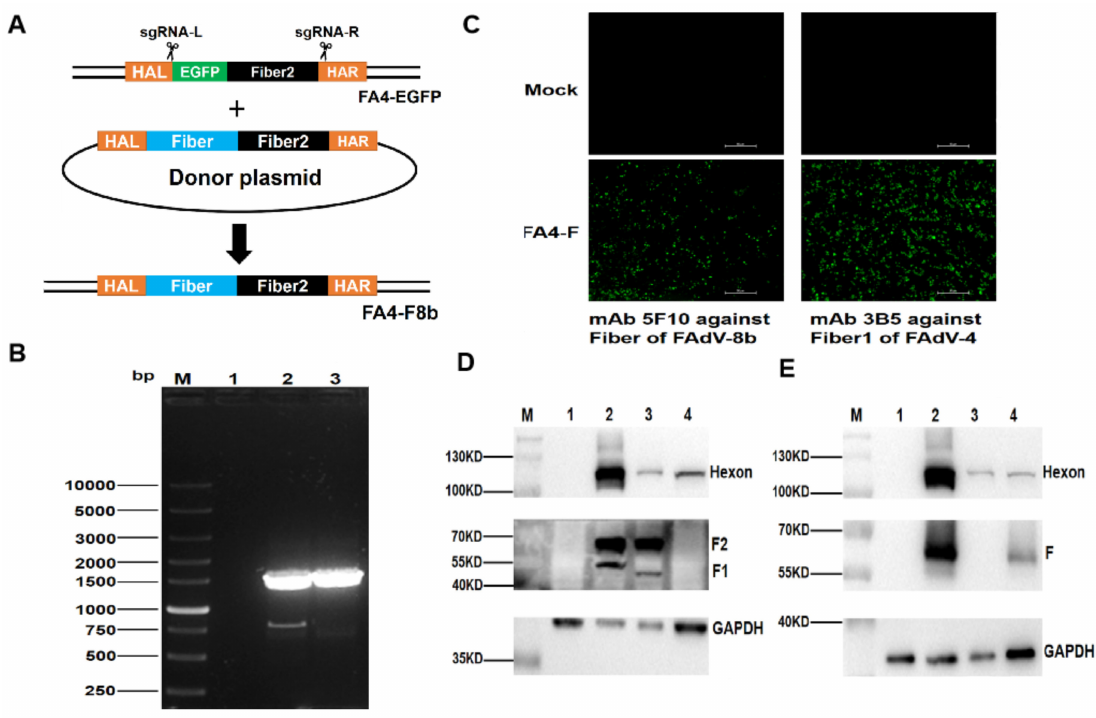
Figure 1. Generation of the recombinant FA4-F8b expressing fiber of FAdV-8b. ( A )The homology- dependent knock-in strategy for generating the recombinant virus FA4-F8b using the CRISPR-Cas 9 system. LMH cells were simultaneously transfected with two sgRNAs and donor plasmid. Then, the LMH cells were infected with FA4-EGFP at 24 hpt. The recombinant virus FA4-F8b was then purified by viral plaque assay and limiting dilution assay. ( B ) The purified FA4-F8b was detected by PCR. The LMH cells (Lane 1), the unpurified FA4-F8b (Lane 2) and the purified FA4-F8b (Lane 3) were detected using specific primers (Ad8T-F and Ad8T-R). ( C ) The purity and the expression of fiber of the purified FA4-F was detected by IFA. LMH cells were infected with the purified FA4-F8b. mAb 3B5 against Fiber-1 of FAdV-4 and mAb 5F10 against fiber of FAdV-8b were used to test the purified FA4-F8b, respectively. The uninfected LMH cells were set as negative control. ( D ) Western